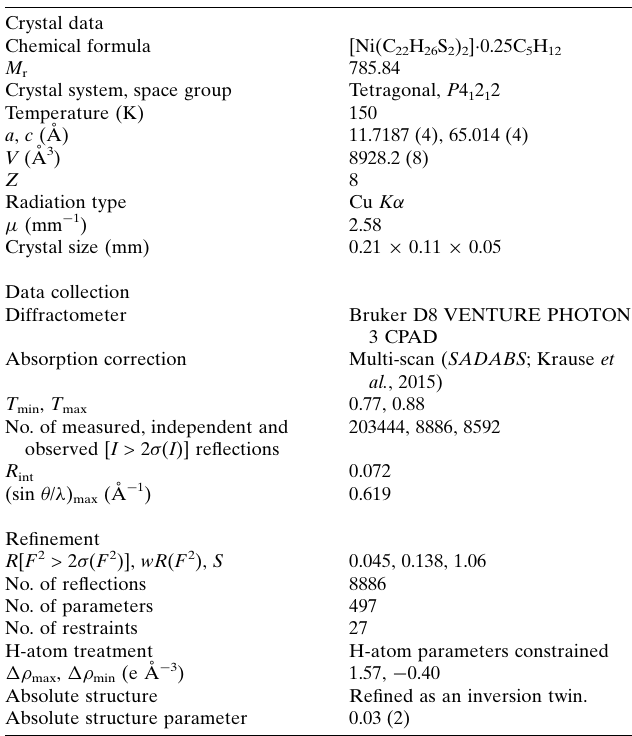
Table 2 Experimental details. Crystal data Chemical